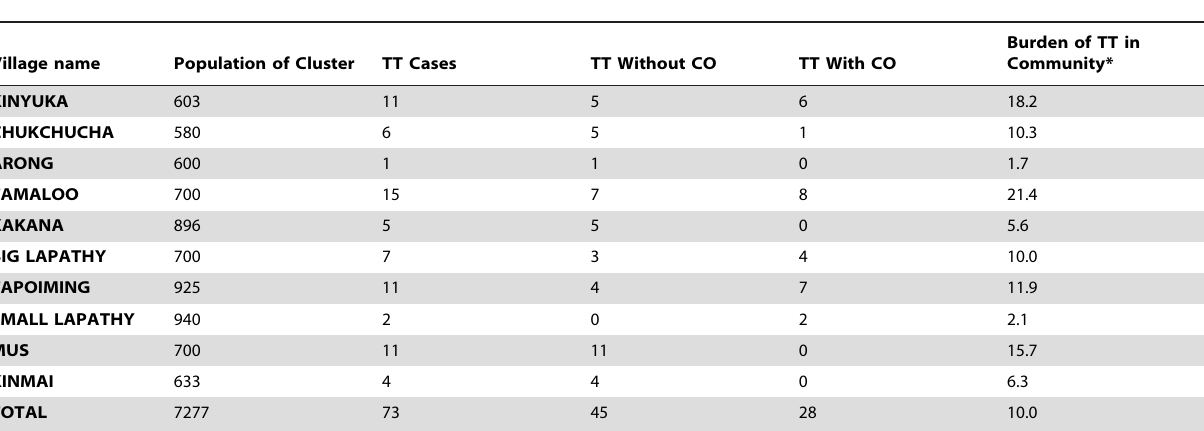
Table 2. Burden of Trachomatous Trichiasis in adults residing in Car Nicobar Island.